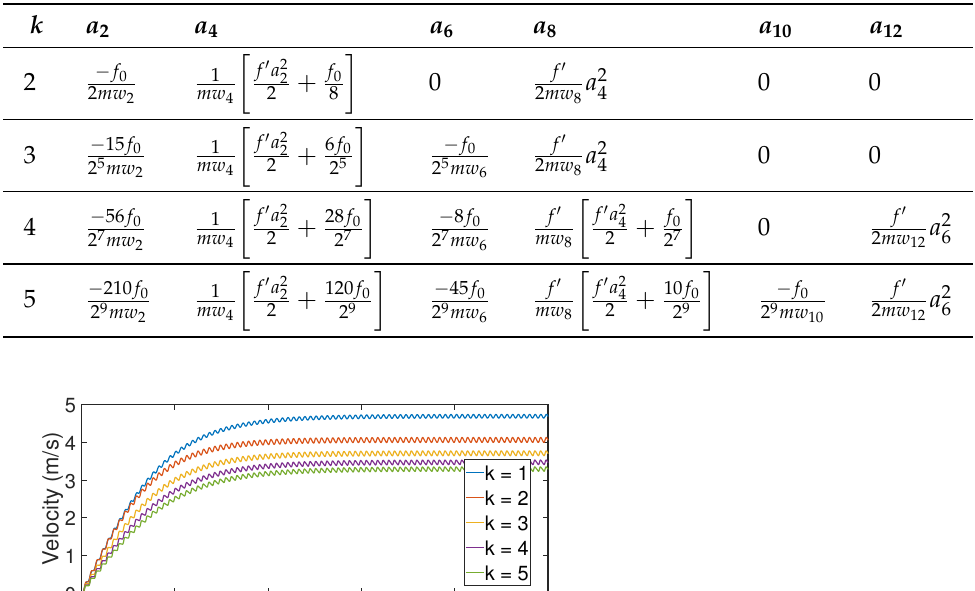
Table 3. Table with the obtained coefficients.